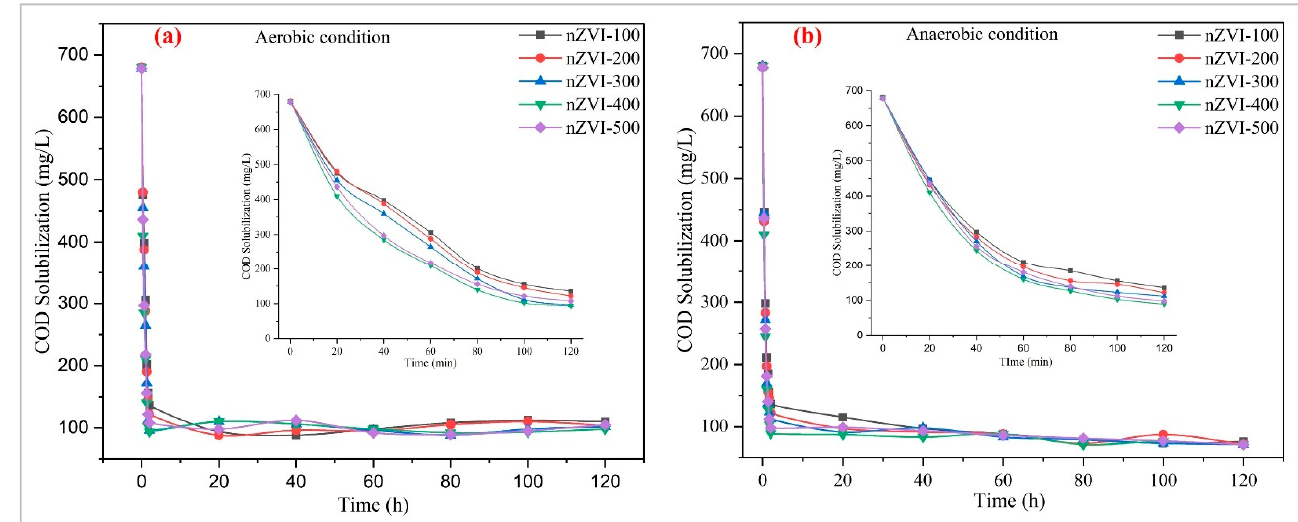
Figure 6. COD solubilization at different dosage of nZVI and conditions: ( a ) aerobic; the first 120 min of the aerobic treatment (inset) ( b ) anaerobic; the first 120 min of the anaerobic treatment (inset).